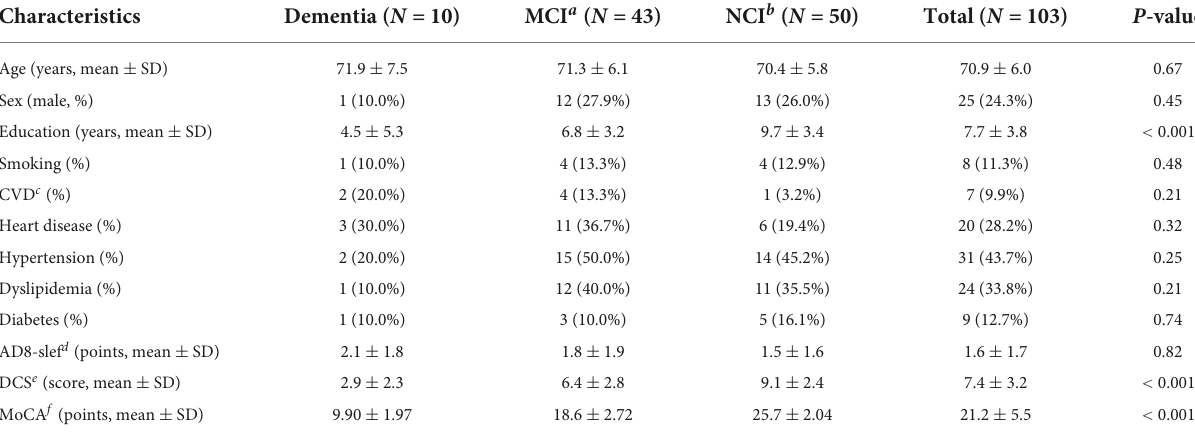
TABLE 1 Participant